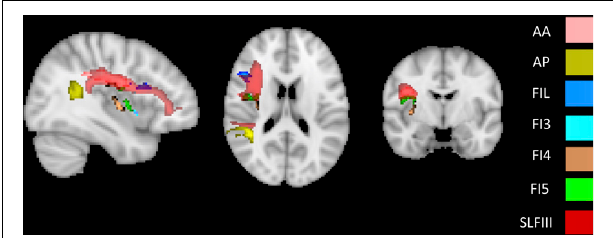
FIGURE 4 | White matter tracts more commonly disconnected in AHP: main white matter tracts involved in AHP disconnection map as compared to HP. FI: fronto-insular tract; SLF III: superior longitudinal fasciculus III; AA and AP: anterior and posterior segment of arcute fasciculus; FIL: frontal inferior longitudinal